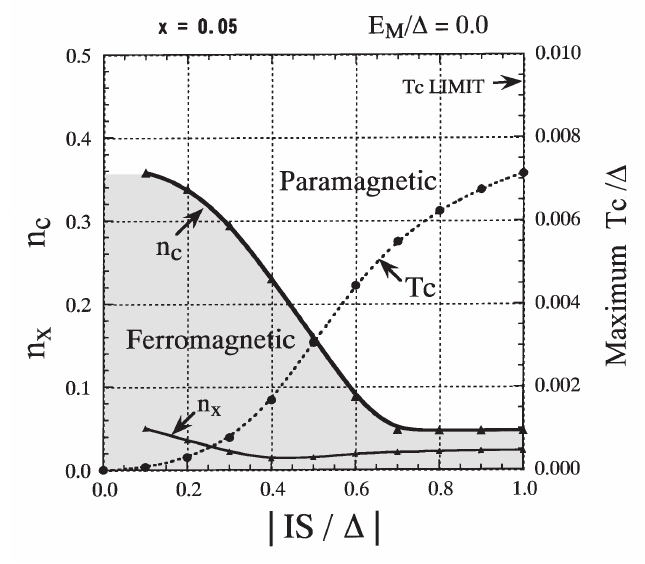
Figure 10. Phase diagram for E line; left scale) and the maximum T functions of | IS | = ∆ . The carrier density n is included (solid line; left scale). From Takahashi and Kubo